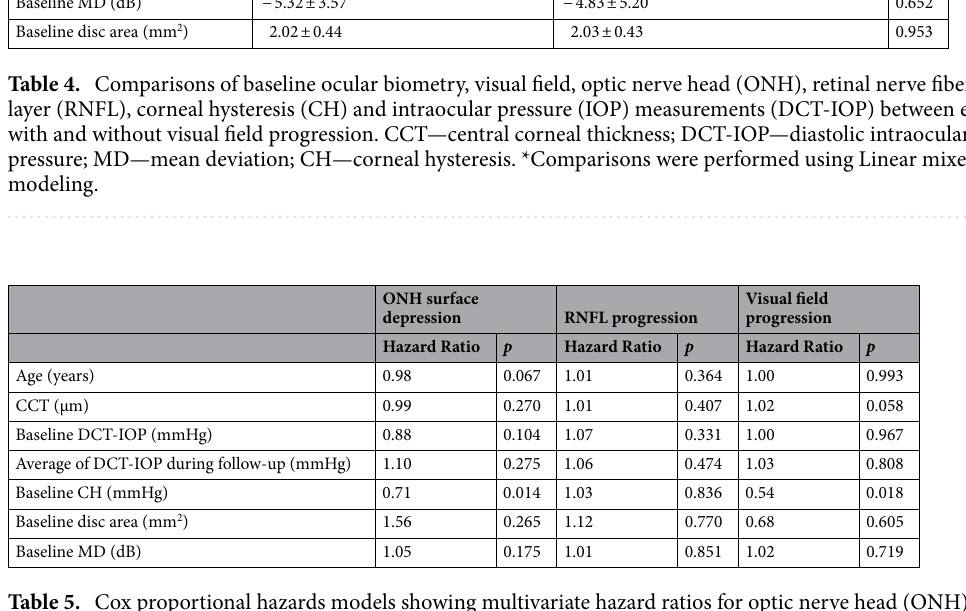
Table 5. Cox proportional hazards models showing multivariate hazard ratios for optic nerve head (ONH) surface depression, retinal nerve fiber layer (RNFL) progression and visual field progression after adjusting ages, CCT, baseline DCT-IOP, average DCT-IOP during follow-up, baseline disc area and baseline MD. CCT— central corneal thickness; DCT-IOP—diastolic intraocular pressure; MD—mean deviation; CH—corneal